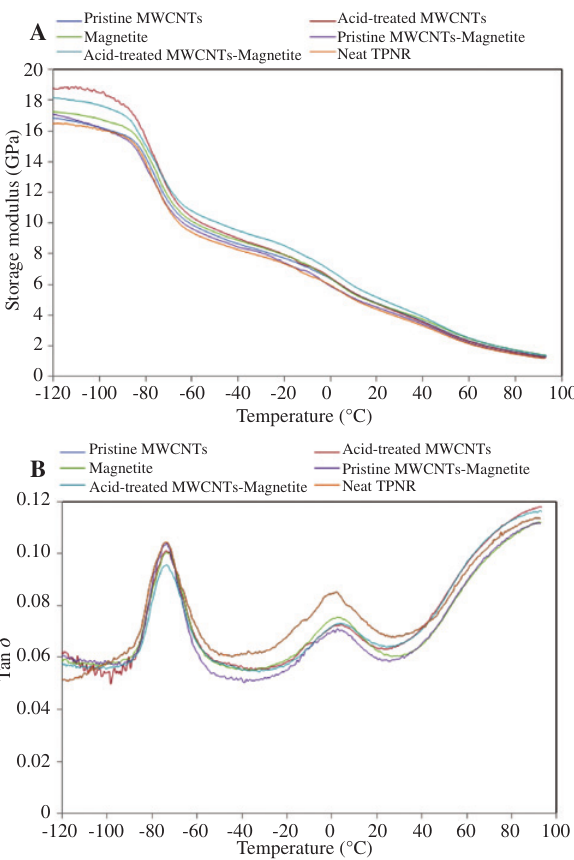
Figure 7 DMA of the neat TPNR and its nanocomposites: (A) storage modulus vs. temperature and (B) tan( δ ) vs.